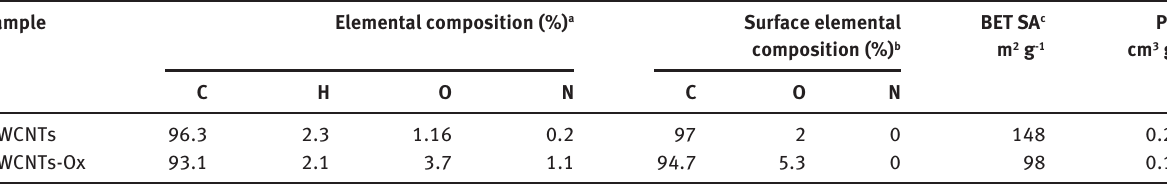
Table 1: Bulk and surface elemental characterization of multi-walled carbon nanotubes (MWCNTs). Sample Elemental composition (%) a